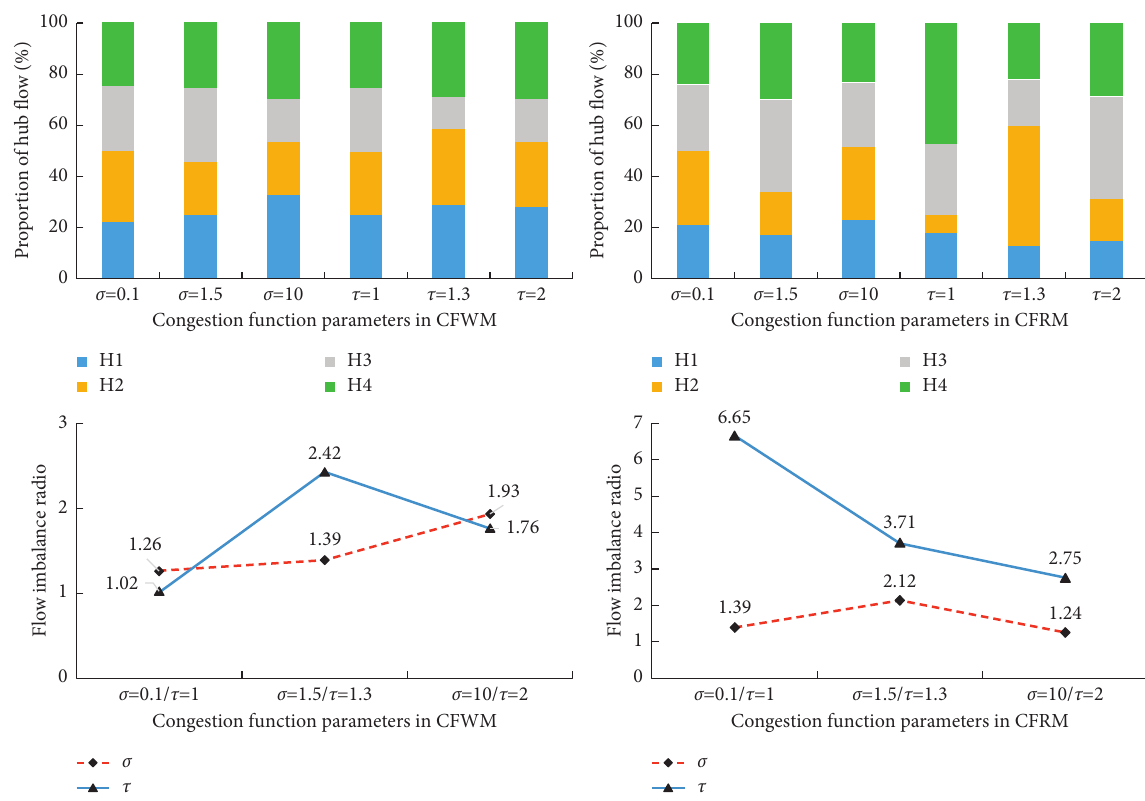
Figure 5: Impact of congestion parameter change on flow proportion and flow imbalance ratio at each